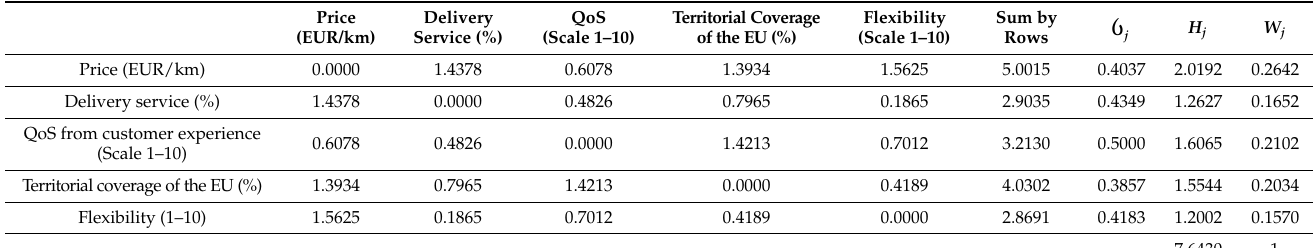
Table 9. m × m matrix with the final weights (Source: Authors).